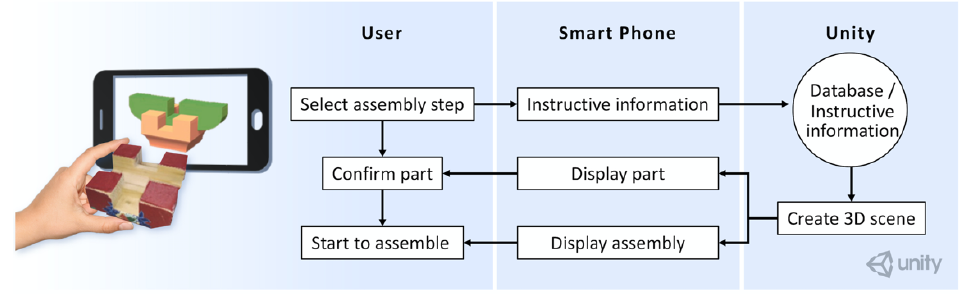
Figure 5. Framework design of 3D viewer-based system.